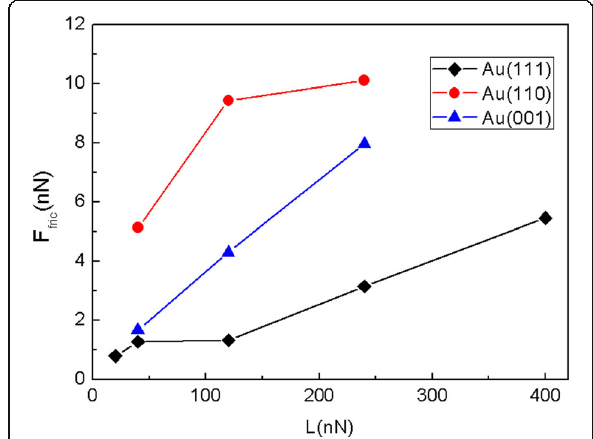
Fig. 8 The average friction force F fric of the 5.8-nm square flake sliding on the Au substrates with different crystal orientation at different normal